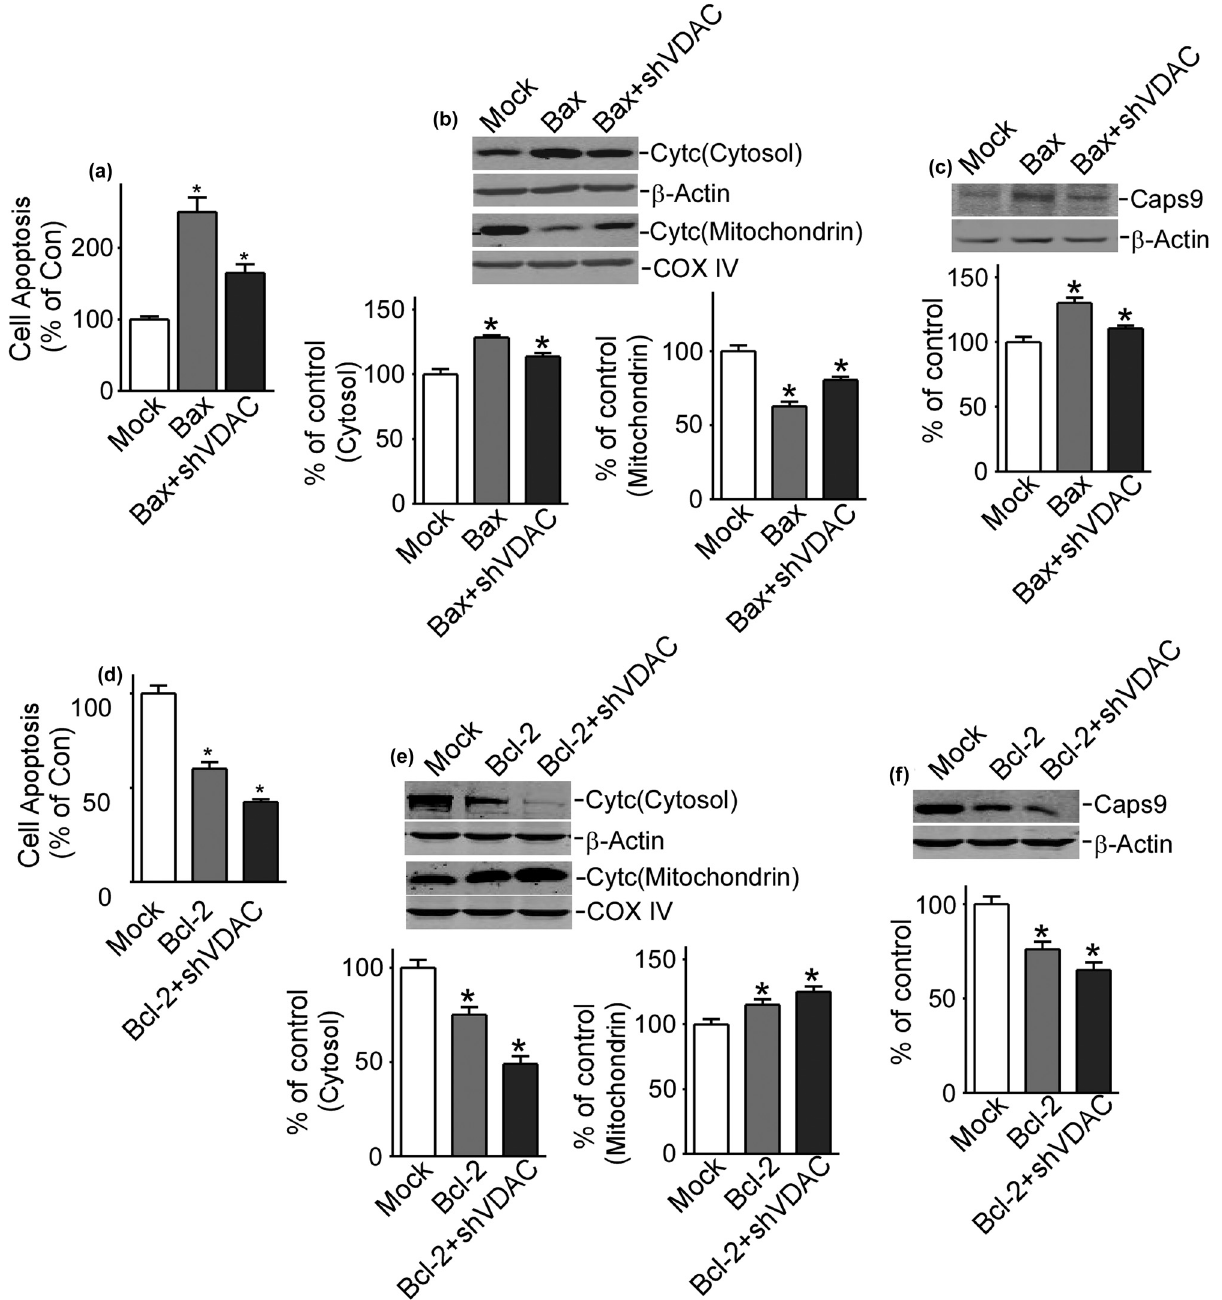
Figure 5: VDAC1 regulates the e ff ects caused by Bax and Bcl - 2 in epilepsy. ( a – c ) Cell apoptosis, the release of Cyt C , and the expression of Caps9 with upregulation of Bax, or upregulation of Bax and downregulation of VDAC1. ( d – f ) . Cell apoptosis, the release of cytochrome C , and the expression of caspase 9 with upregulation of Bcl - 2, or upregulation of Bcl - 2 and downregulation of VDAC1. Cytc means cytochrome C , Caps9 means caspase 9. Values represent means ± SD, n = 3. P < 0.05 by Student ’ s t -